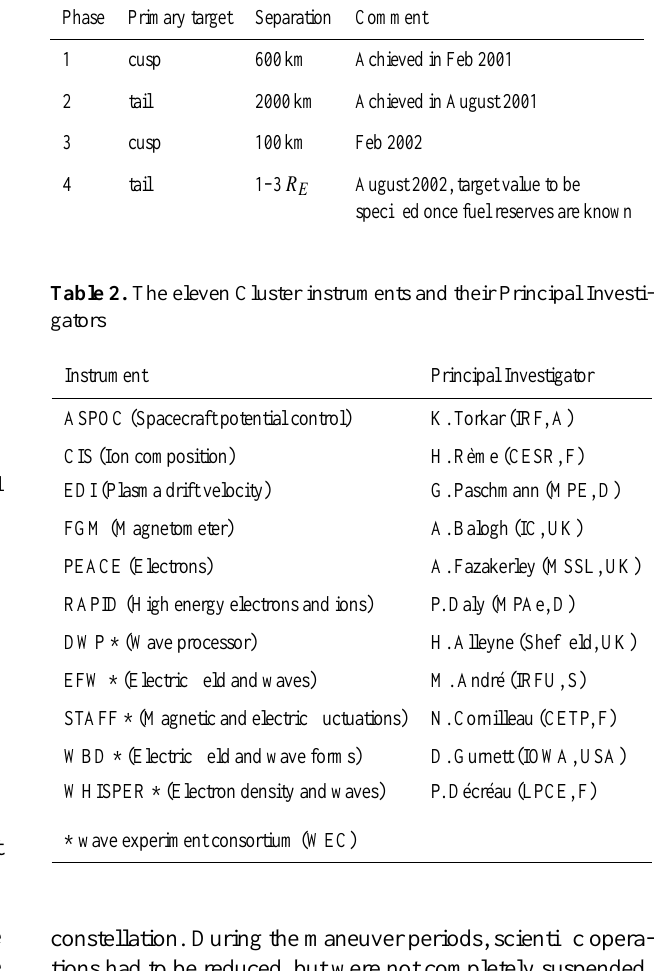
Table 1. The Cluster spacecraft separation strategy